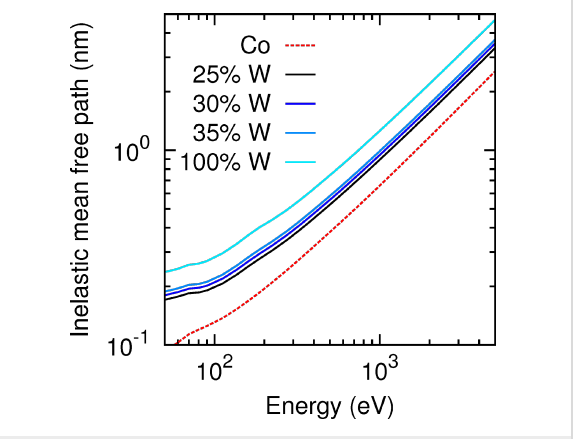
Figure 11: IMFP in different deposits with fixed composition (27.5% W, 50.4% C, 22.1% O) and a variable density.